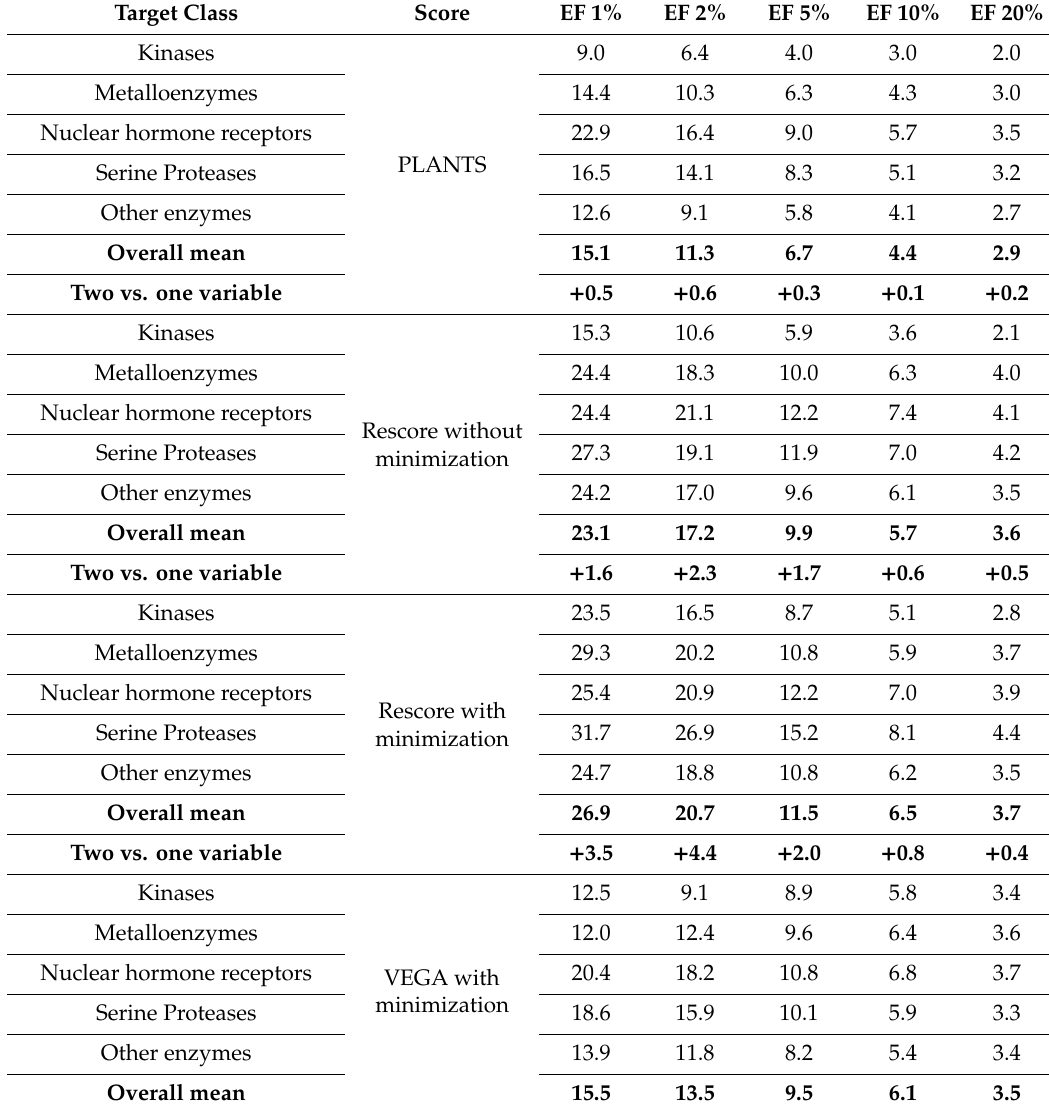
Table 2. Enrichment factor averages for the two-variable equations as generated by the EFO